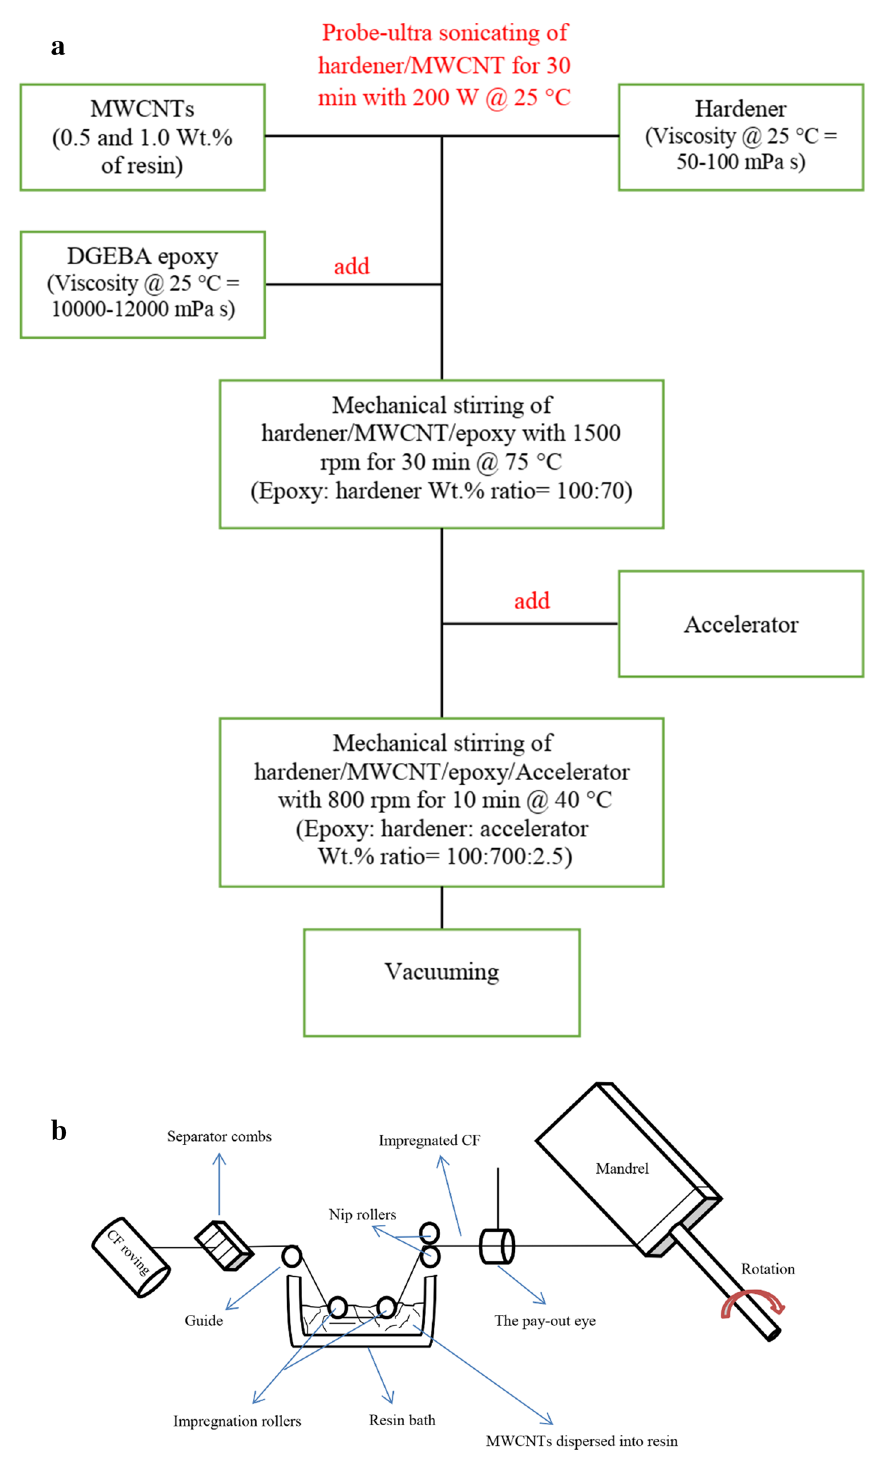
Fig. 2 Schematic of ( a ) MWC- NTs dispersion into epoxy resin and ( b ) filament winding pro- cess for fabricating